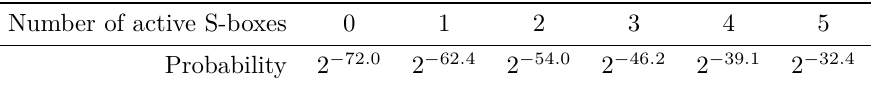
Table 5: Probability that a random data-round key difference leads to x active S-boxes for 5 R ′ , or 5 R